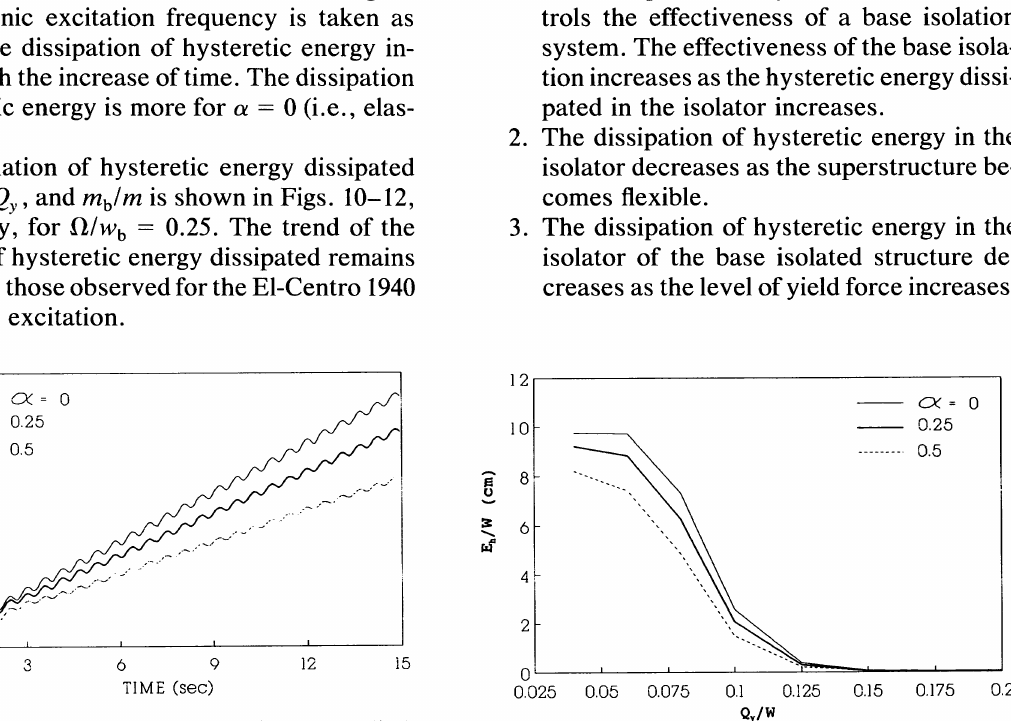
FIGURE 11 Variation of hysteretic energy dissipated against Q/W; T = 1 sand mb1m =